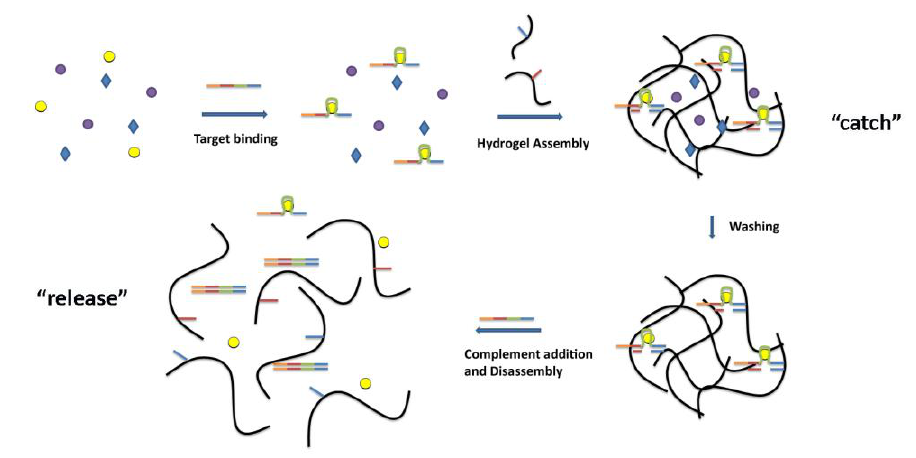
Figure 2. Catch and release smart materials: A crosslinker strand (orange-red-green-blue) containing an aptamer domain (green) for the target of interest (yellow circles) binds to the target and assembles the hydrogel through complementary interactions with the DNA-polymer conjugates (red and blue). After washing to remove any nonspecifically-held species, the purified target can be “released” through disassembly of the gel. This is accomplished by introducing a fully complementary strand that can unzip the crosslinker strand from the DNA-polymer conjugates starting at a single-stranded toe-hold sequence (orange). (modified from reference